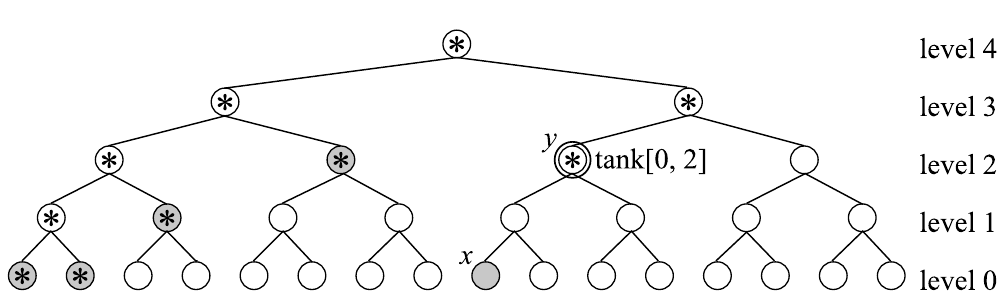
Figure 3. A semi-compact